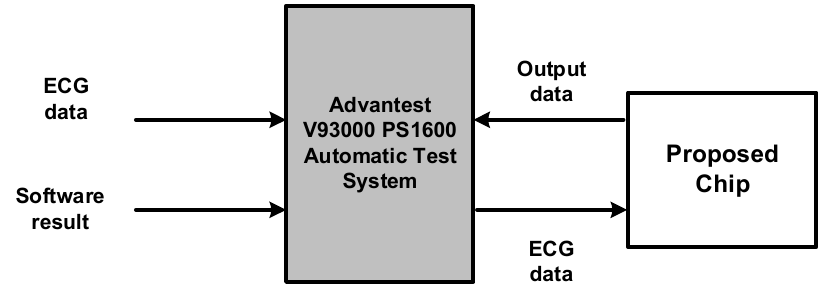
Figure 7. The block diagram of chip testing.